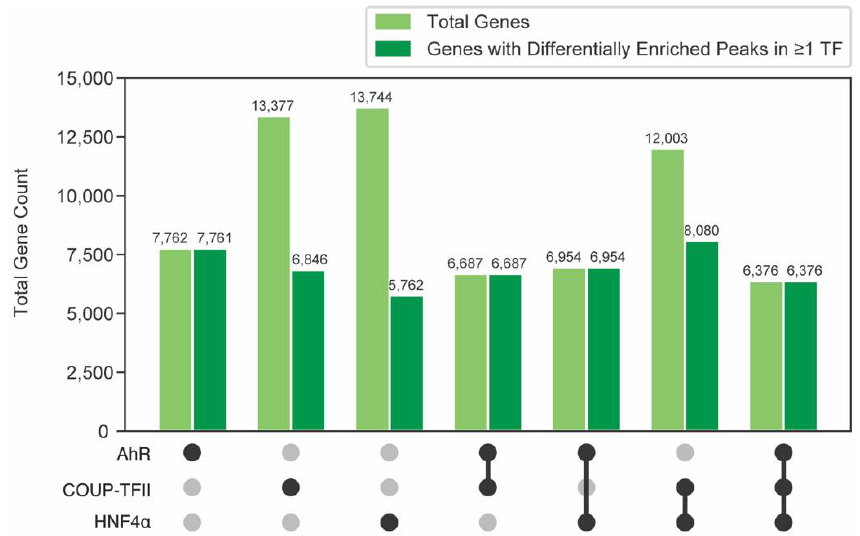
Figure 4. Evaluating putative co-regulated gene targets. The total number of hepatic genes associated with AhR, COUP-TFII and HNF4α enrichment in intragenic regions in ChIPseq data using mouse liver samples 2 h after TCDD treatment. Black circles denote the presence of genes for each transcription factor dataset. Common genes among transcription factor datasets are also identified and are referred to as “intersections”. The number of genes possessing at least one enriched peak following TCDD treatment are denoted in dark green.